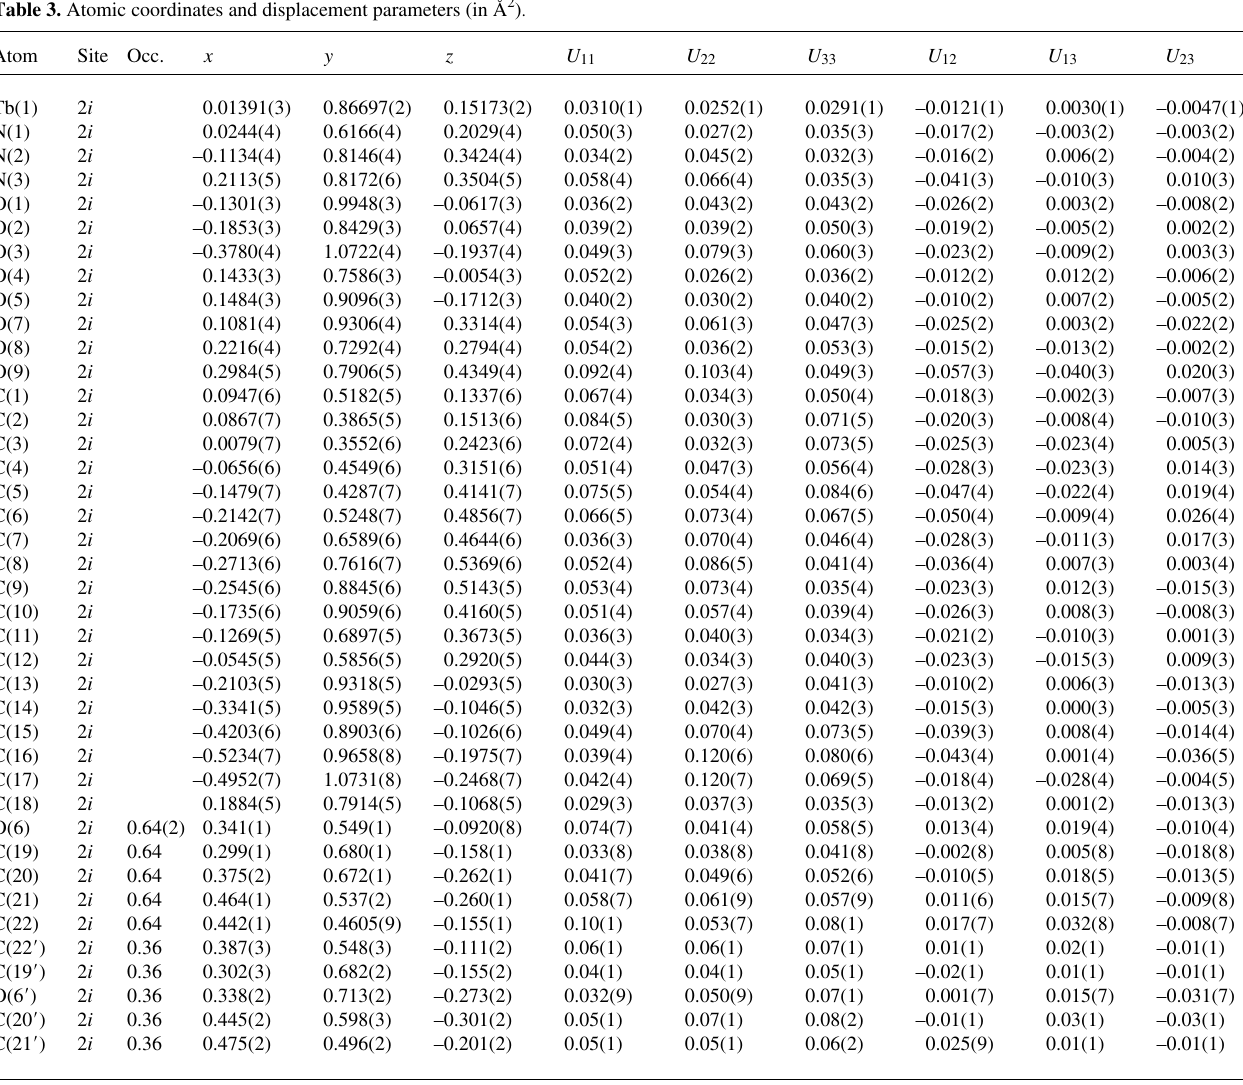
Table 3. Atomic coordinates and displacement parameters (in Å 2 ) .